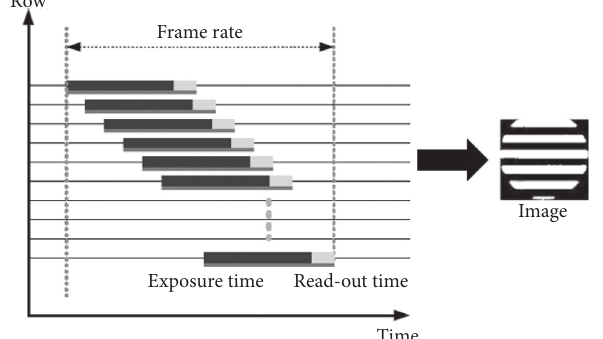
Figure 6: Rolling shutter mechanism of the CMOS image sensor and the LED image